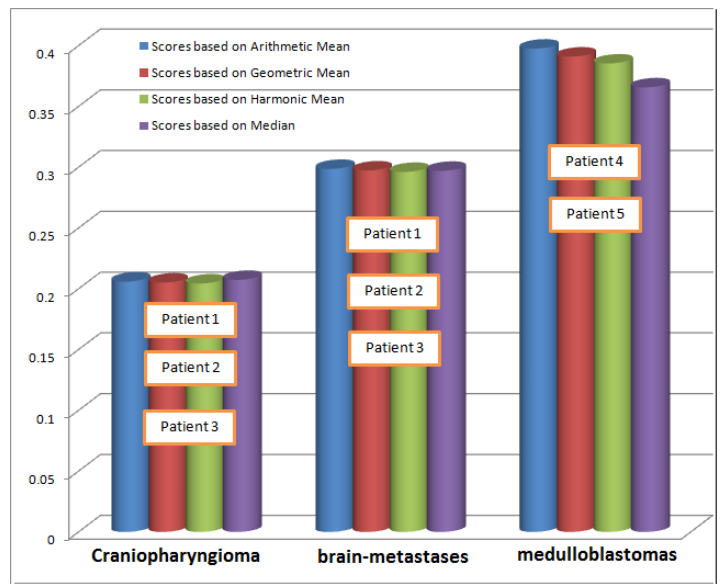
Figure 9. Comparison of scores computed through different statistical techniques. Table 17. Structural comparison of proposed study with the most relevant existing